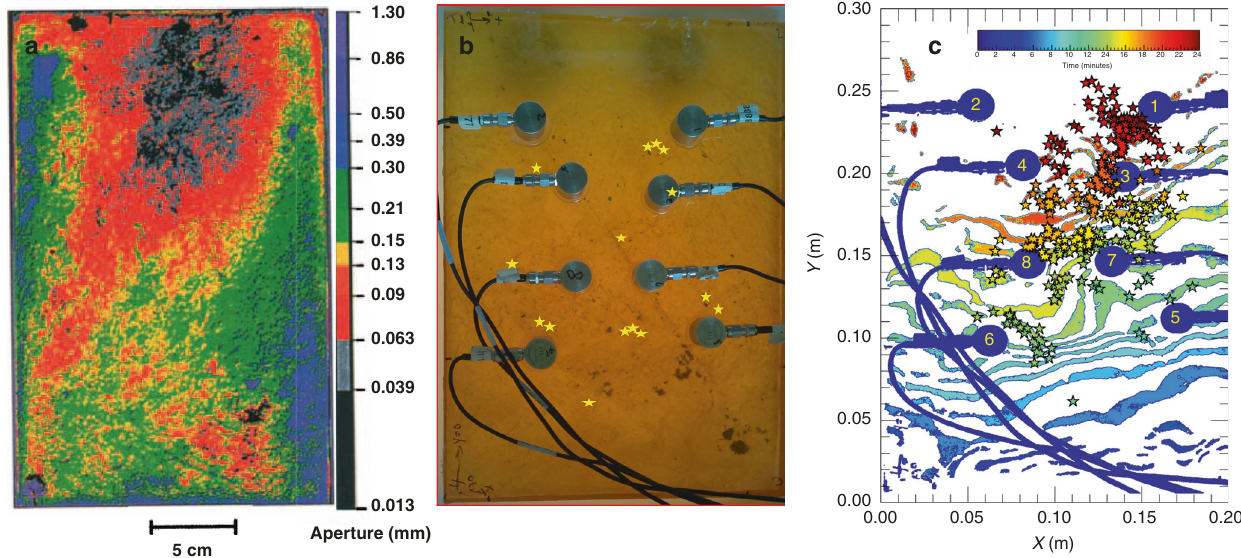
Fig. 4 Acoustic emissions during fl uid invasion in a dust-seeded fracture. a The aperture map adapted from Su et al. 25 with the color representing the size of the aperture in mm. b A digital image of the fracture sample with AE sensors. Yellow stars indicate the location of individual dust grains. c Time- lapse of acoustic emission locations from an imbibing fl uid front ( + y -direction is the imbibition direction) in a fracture pre-seeded with chattering dust. The sensor locations are shown in blue with the sensor number in yellow. The color scale represents time for both the invasion contours and the AE events (stars). The stars indicate the triangulated locations of the individual events. Each invasion contour represents the region the fl uid invaded during a 20 s window with 60 s between the near-borehole scale. The location uncertainty is caused by the water – air interface, the fracture roughness, and the high-angle detection geometry (see Supplementary Note 4).